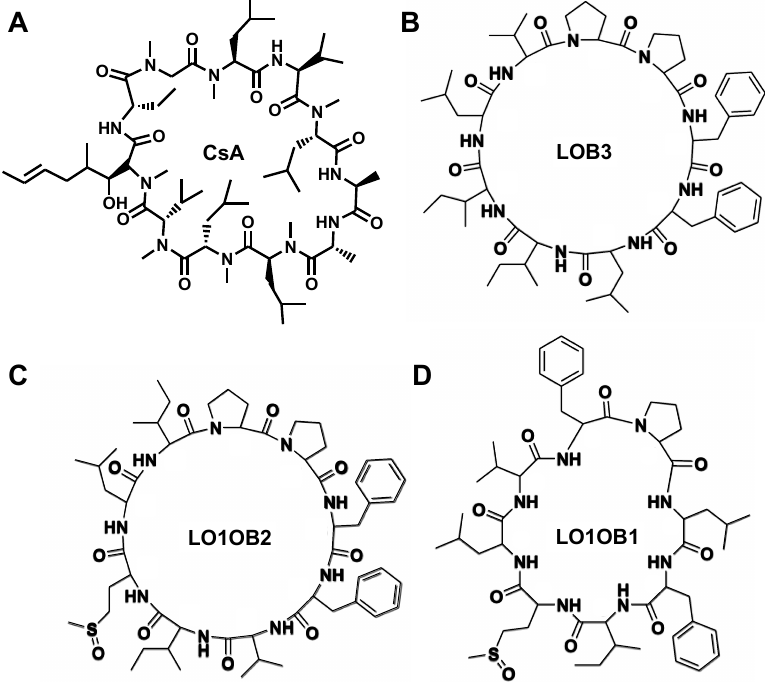
Figure 1. Chemical structures of ( A ) CsA and ( B – D ) LOs. Heat shock proteins (HSP) are often expressed when stressors denature an organism’s protein. In order to stabilize denaturing proteins, chaperones (e.g., HSPs) are expressed to assist in refolding denatured proteins while facilitating the recycling of irreversibly denatured proteins [25].